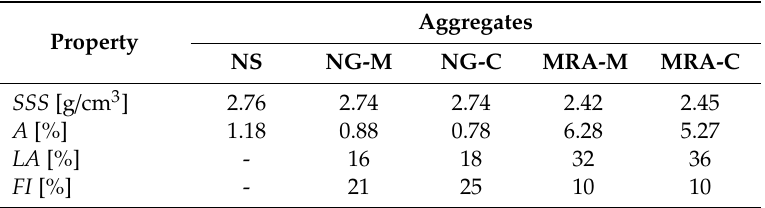
Table 1. Physical and mechanical properties of the